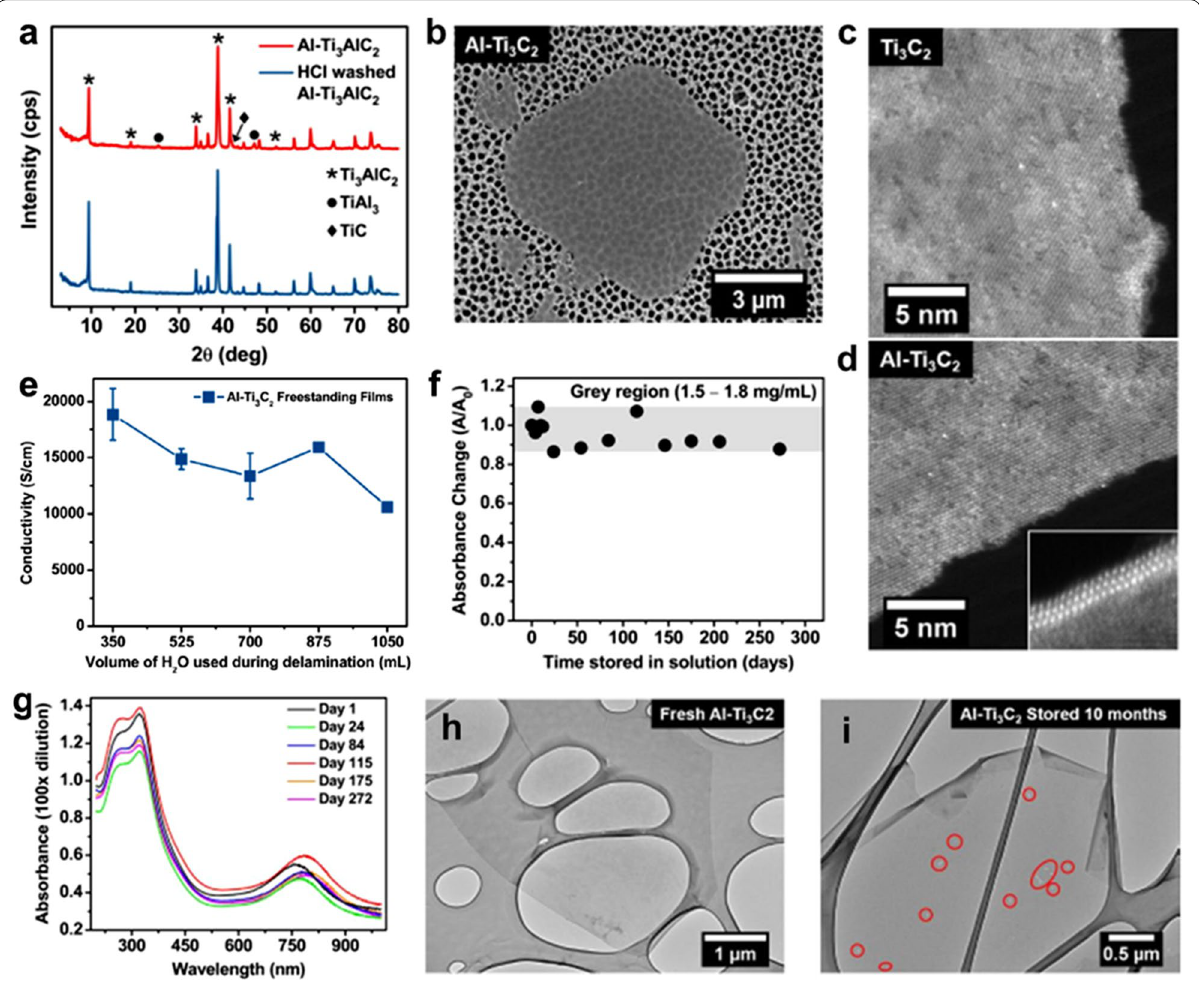
Fig. 4 a X-ray diffraction patterns of Al-Ti 3 AlC 2 before (red) and after (blue) HCl washing. b SEM image of a hexagonal, single-layer flake of Al-Ti 3 C 2 produced via HF/HCl etching and LiCl delamination. c , d High-angle annular dark-field scanning transmission electron microscopy (STEM) images of Ti 3 C 2 flake edges produced from conventional Ti 3 AlC 2 , and Al-Ti 3 AlC 2 , respectively. e Electronic conductivity of freestanding films produced by vacuum-assisted filtration of